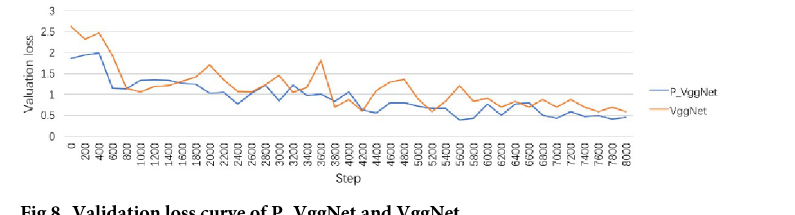
Fig 8. Validation loss curve of P_VggNet and VggNet.